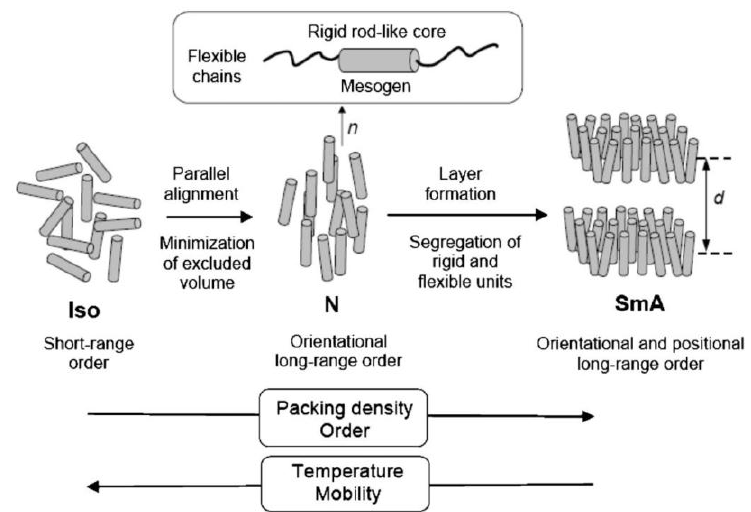
Figure 1. Schematic organization of rod-like molecules in liquid crystal (LC) phases. Reprinted with permission from Reference [4] Copyright 2007 Royal Society of Chemistry.